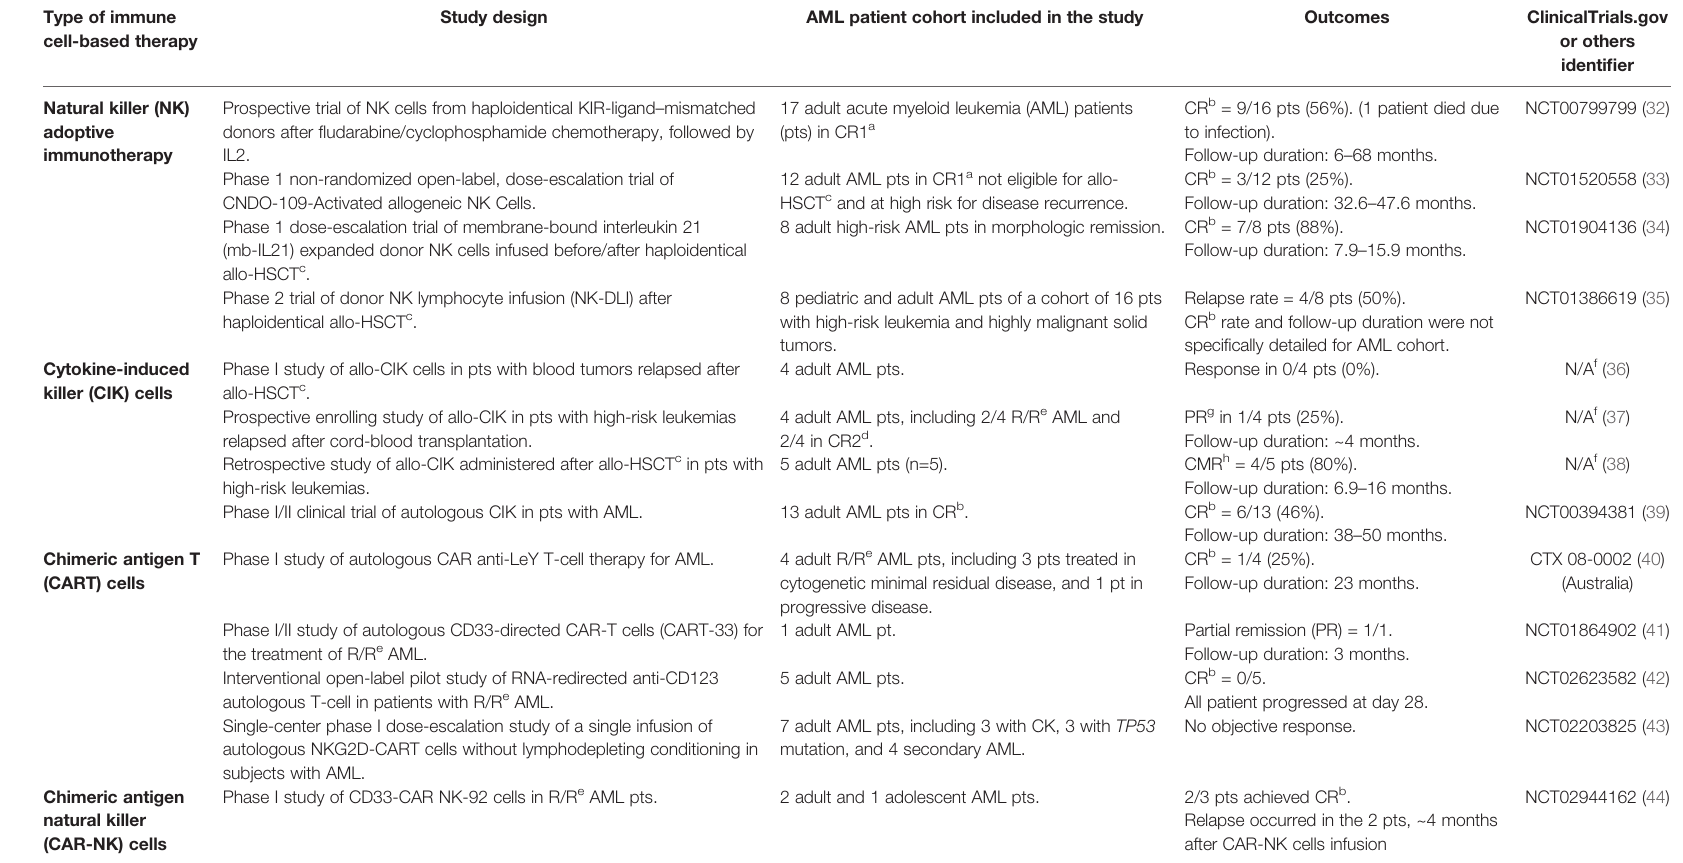
TABLE 1 | | Selected published studies of immune cell-based strategies other than allogeneic transplantation for high-risk acute myeloid leukemia